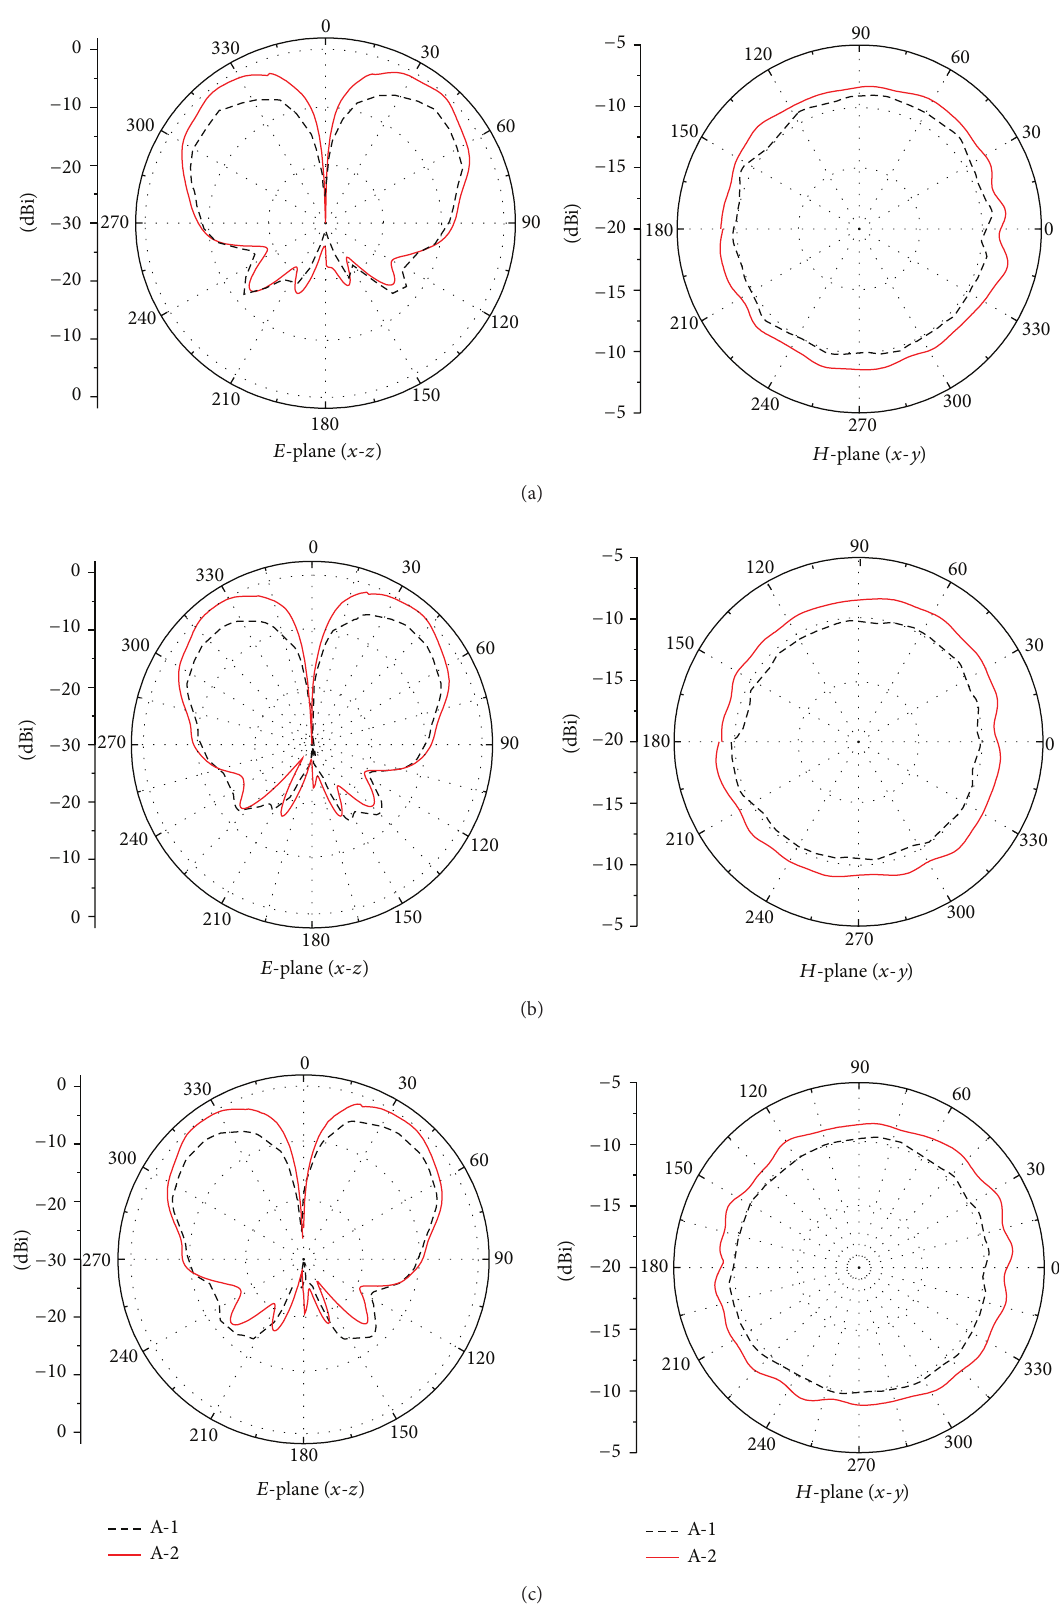
Figure 7: Measured radiation patterns of A-1 and A-2: (a) 5.35 GHz, (b) 5.55 GHz, and (c) 5.65 GHz. The coordinate system here is defined in Figure